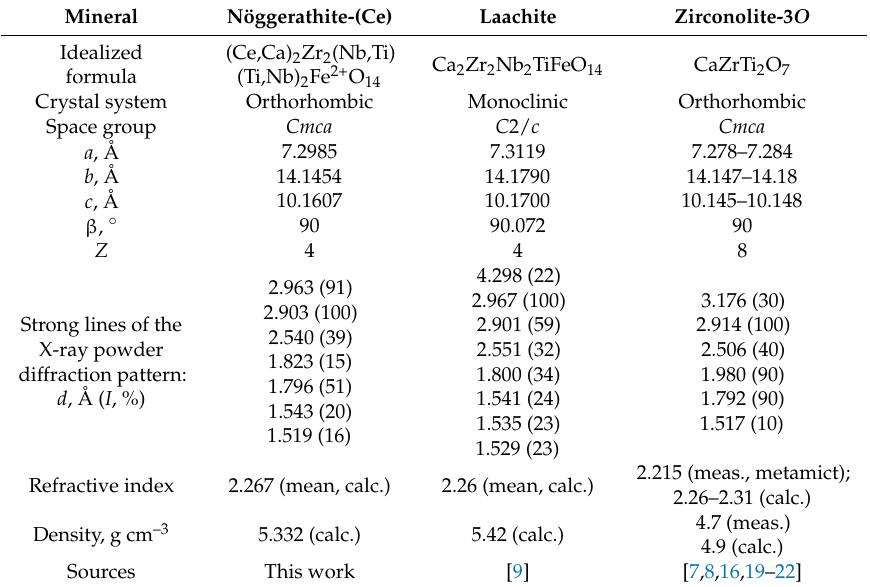
Table 8. Comparative data for nöggerathite-(Ce) and related minerals.